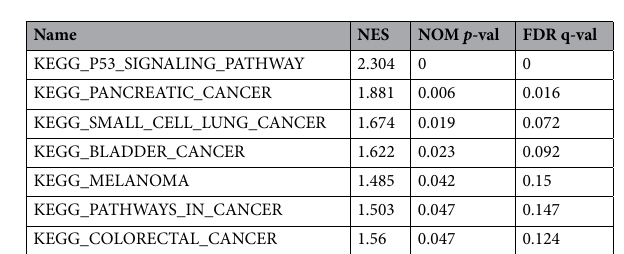
Figure 4. Enrichment plots from GSEA. ( A ) The p53 signaling pathway was differentially over-represented in LUAD cases with the elevated MND1 expression. ( B ) The p53 signaling pathway and pathways associated with pancreatic carcinoma, small cell lung carcinoma, bladder carcinoma, melanoma, and colorectal carcinoma were differentially over-represented in cases with the elevated MND1 expression, whereas the pathways for aldosterone-regulated sodium reabsorption, vascular smooth muscle contraction, PPAR signaling, complement and coagulation cascades, drug metabolism, cytochrome p450, calcium signaling and GNRH signaling were differentially over-represented in cases with low MND1 expression.